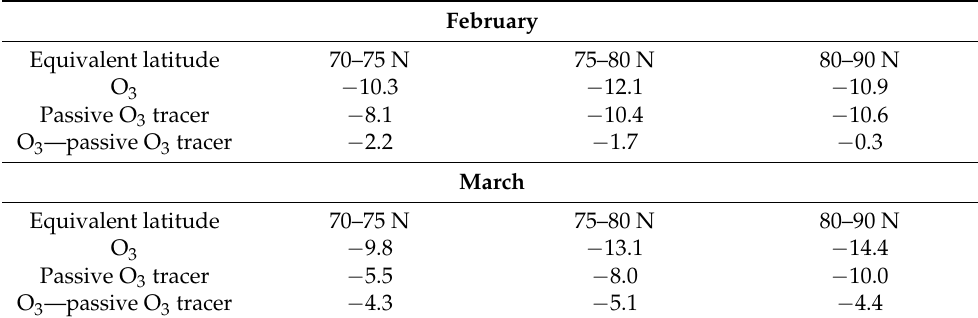
Table 4. Partial column ozone anomaly at 50–100 hPa (DU) for the QBO-W/S min